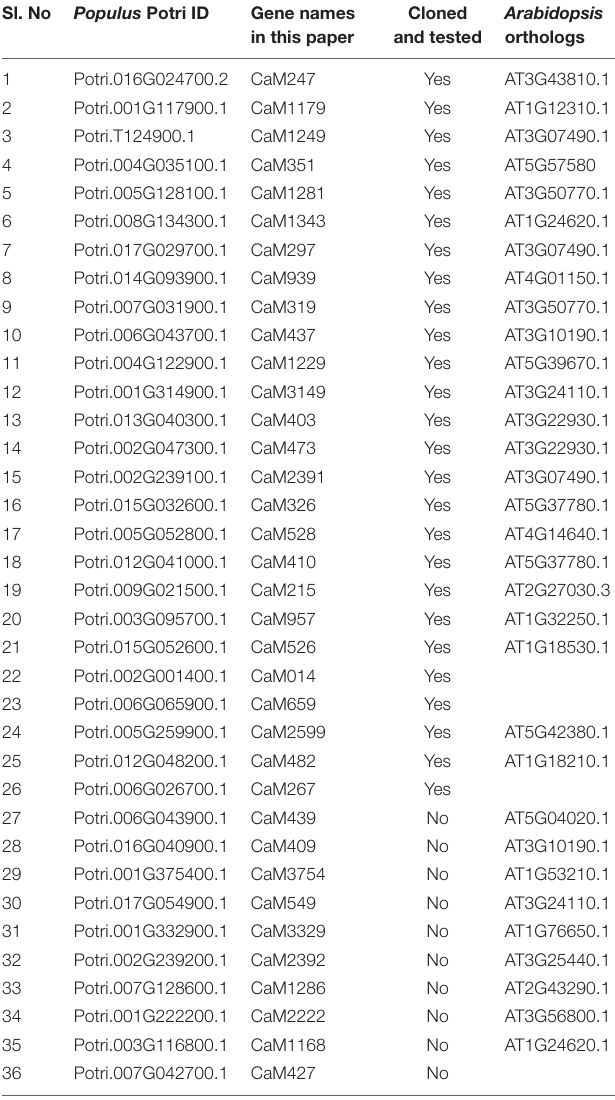
TABLE 1 | List of calmodulin and calmodulin-like proteins employed in the